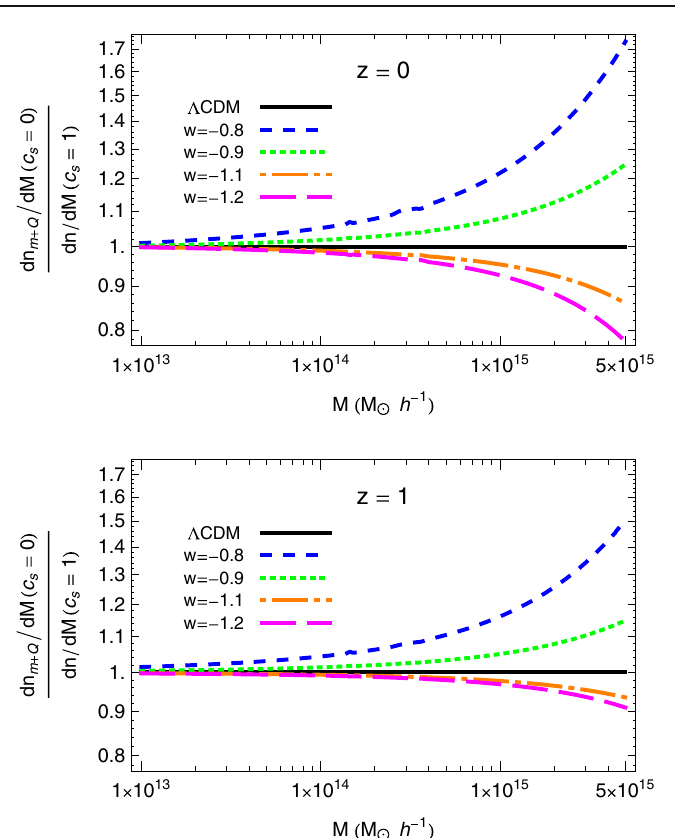
Fig. 5 Ratio of the total mass functions, which include the quintessence contribution, for c s = 0 and c s = 1 at z = 0 (above) and z = 1 (below). Image reproduced by permission from Creminelli et al. (2010); copyright by IOP and SISSA c s = 1 case. The sum of the two effects is rather large: for values of w still